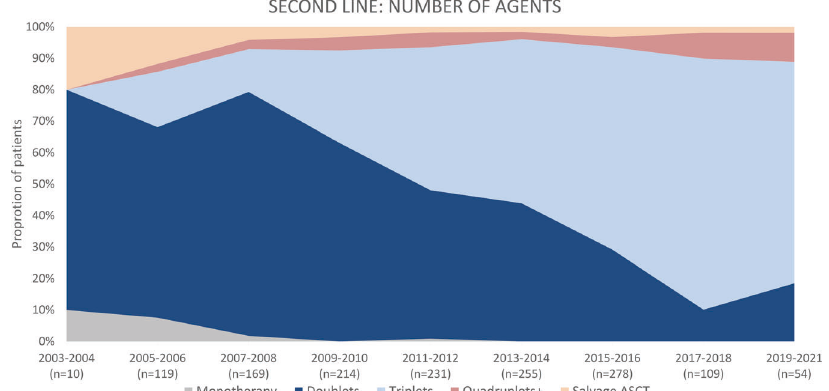
Fig. 1 Number of agents applied as second-line treatment in multiple myeloma patients, initiation of second-line treatment 2003 – 2021. ASCT autologous stem cell